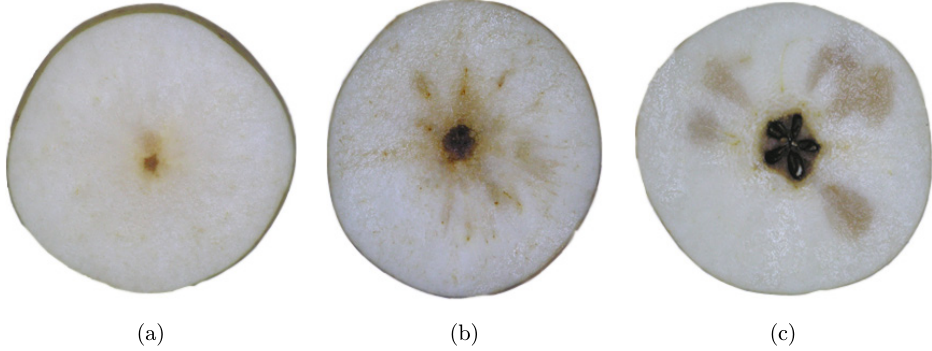
Fig. 3. Normal (a), less than 5% watercore-a®ected (b), and rejected pear